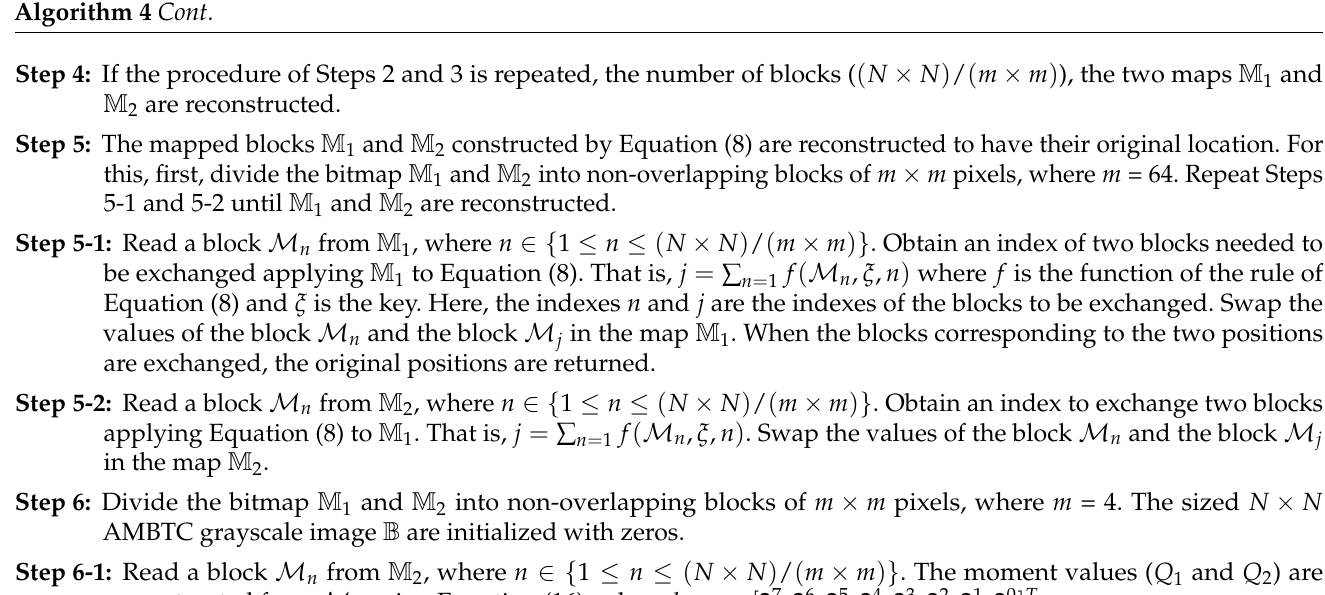
Algorithm 4 Cont.